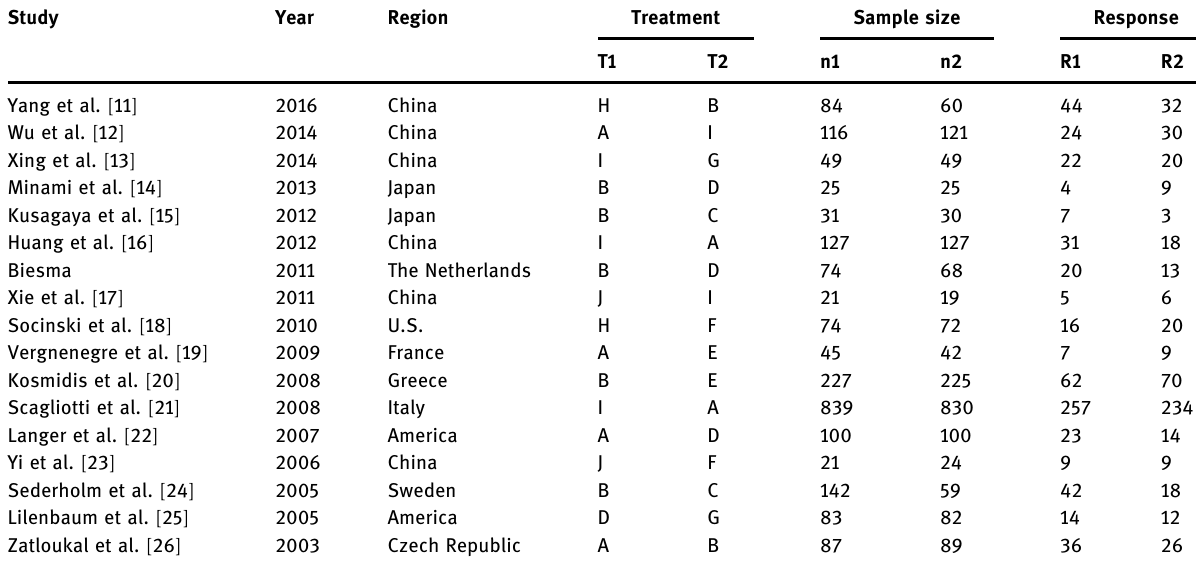
Table 1: General characteristics of the included studies Study